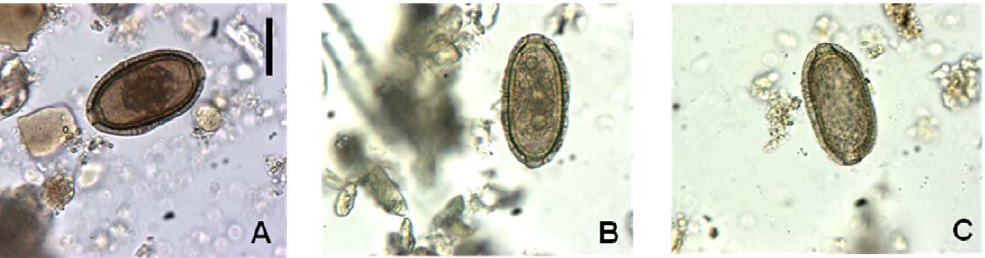
Figure 2. Eggs of Calodiumhepaticum in stool and liver tissue. A. In human stools, B. In peccary liver tissue, C. In dog feces. Scale=31 m m (all images).